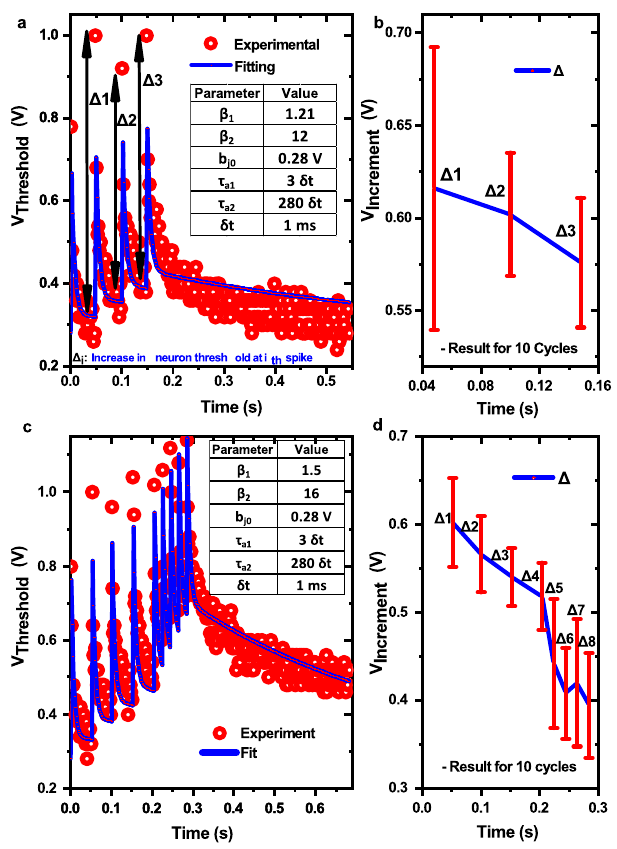
Fig. 6 Hardware DEXAT neuron parameter extraction. a , c Experimentally observed adaptive threshold behavior for spike sequence S1 and S2 respectively showing increment in threshold voltage ( Δ ) at each spiking event and fi tting using DEXAT mode. Extracted parameters for both sequences S1 and S2 are shown in inset of graphs. b , d Variation in threshold voltage increment ( Δ ) for sequence S1 and S2 respectively at each spike event due to C2C device variability and decrease in threshold voltage increment ( Δ ) with subsequent spikes due to device behavior. Error bars represent standard